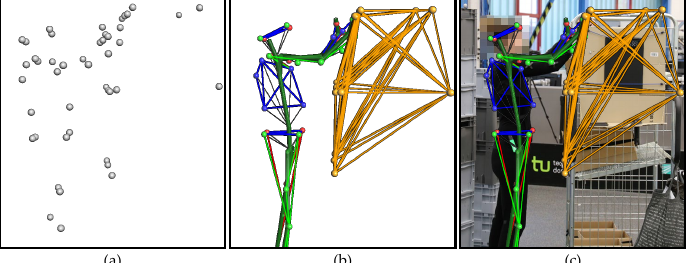
Figure 1. Data processing pipeline of the oMoCap system based on a person to goods order picking process: ( a ) Reconstruction of a point cloud consisting of markers. ( b ) Marker labelling based on patterns of markers from the subject and the picking cart. ( c ) Overlay of the oMoCap visualisation with the video